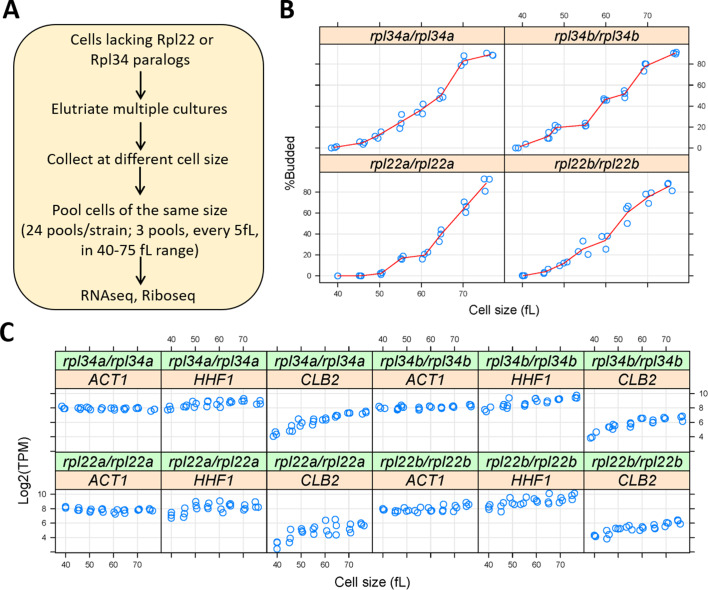
Querying synchronous, dividing cells lacking ribosomal protein paralogs.(A) Schematic of our experimental approach to identify gene expression changes in rpl22 and rpl34 paralog mutants at the transcriptional or translational level, from cells at several different stages of the cell cycle. (B) Cell size (in fL, x-axis) and the percentage of budded cells (%Budded, y-axis) from each pool of the indicated strains. The values shown are the weighted averages, from the different elutriated samples in each pool. (C) On the y-axis, are the Log2-transformed TPM values from representative transcripts known to increase in abundance in S (histone H4; HHF1), G2 phase (cyclin CLB2), or are constitutively expressed (ACT1). Cell size is on the x-axis.Figure 3—source data 1.Raw read sequencing data.Figure 3—source data 2.TPM-normalized sequencing data.